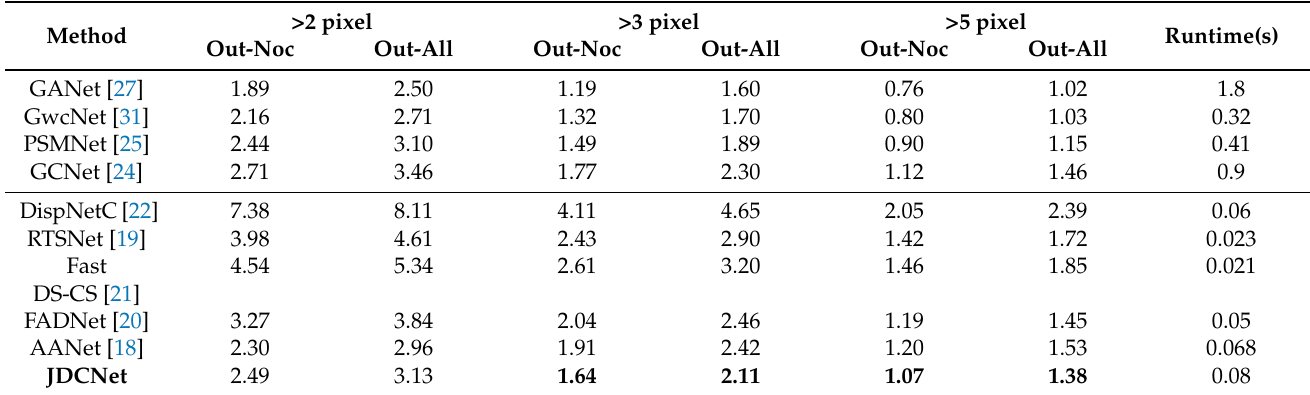
Table 3. The official results on KITTI 2012 benchmark. The first four are classic 3D stereo methods, while the others are fast stereo networks. We collect the data from the KITTI offical website. Only published methods are listed for comparison. Bold denotes important metrics or the best results in all fast stereo networks.